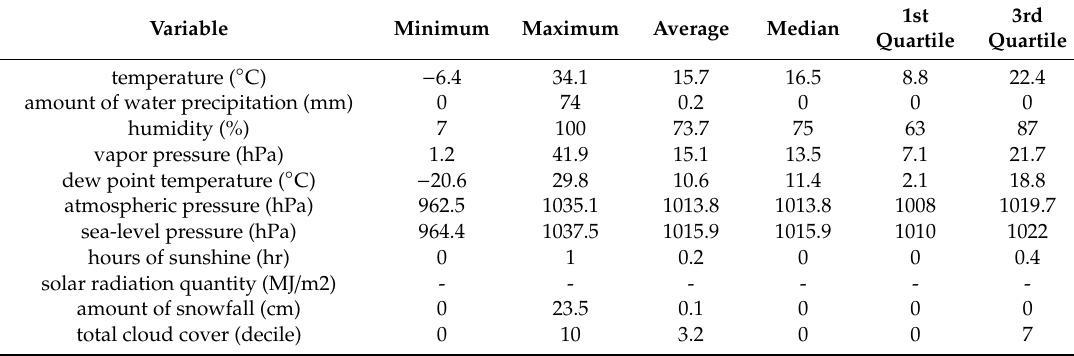
Table 10. Basic statistics for hourly data in coastal area